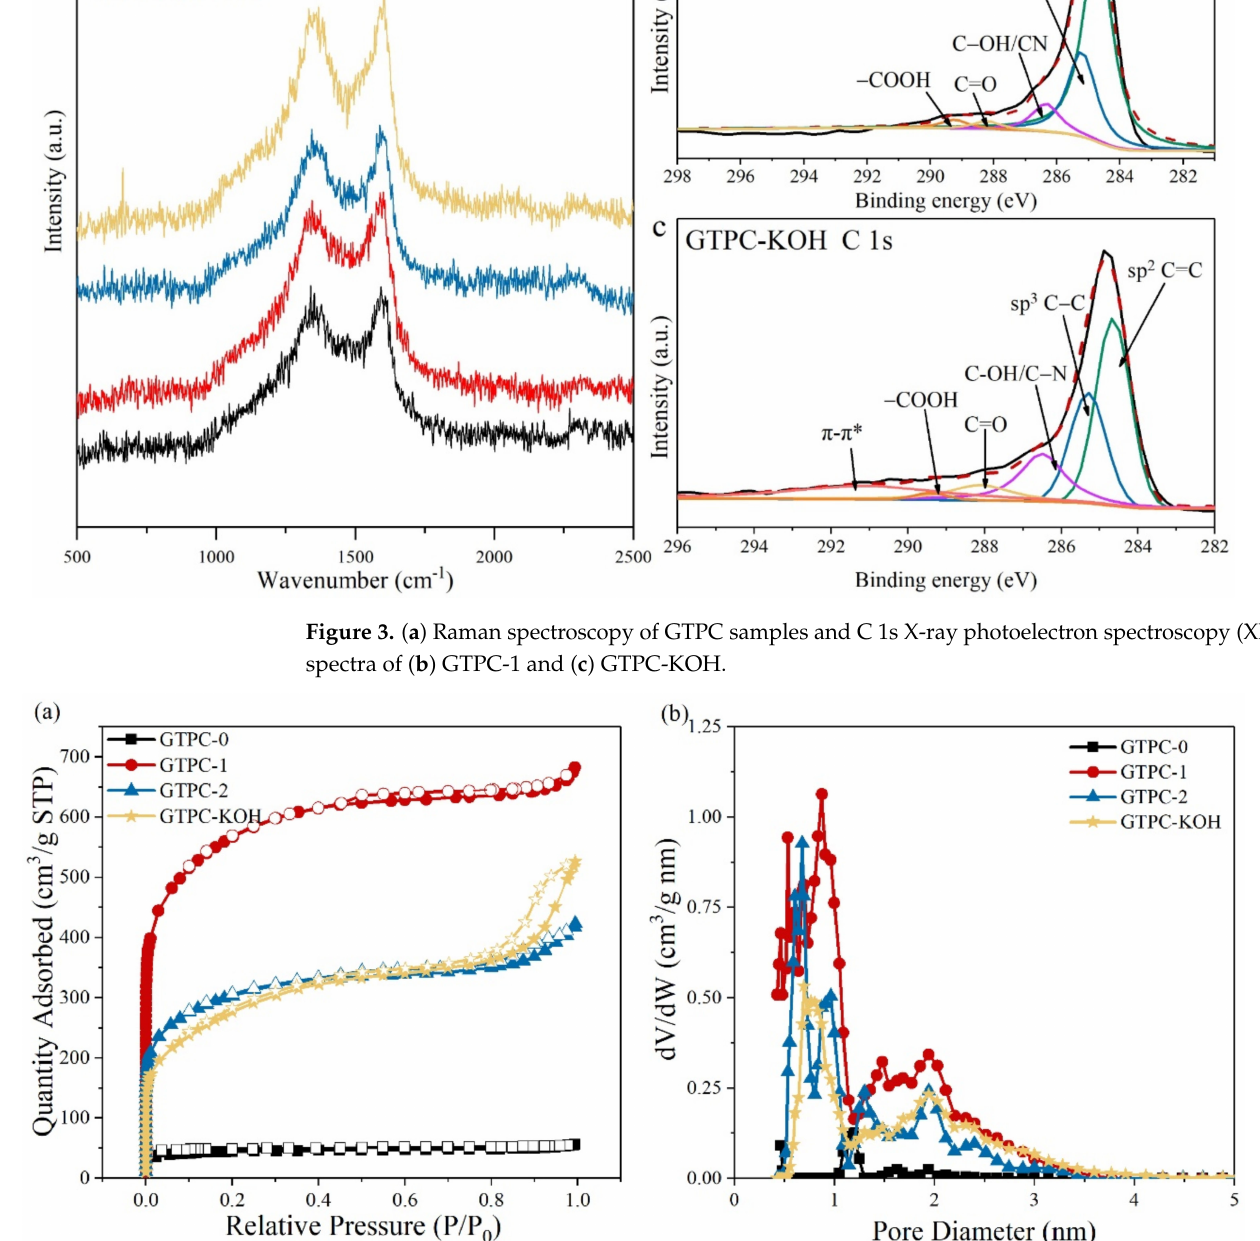
Figure 4. ( a ) Nitrogen adsorption–desorption isotherm and ( b ) pore size distribution of GTPC